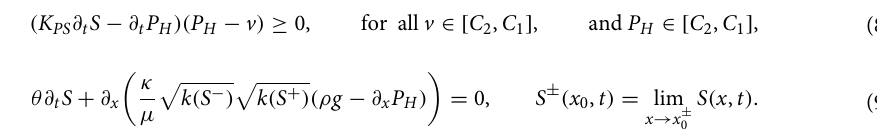
Figure 6. Convergence of the moisture profile in 2D at time t cm, 0.125 cm and 0.0625 cm from the left to the right for initial saturation S in converges and retains the overshoot pattern. Saturation values are colour-coded according to the colour bar on the